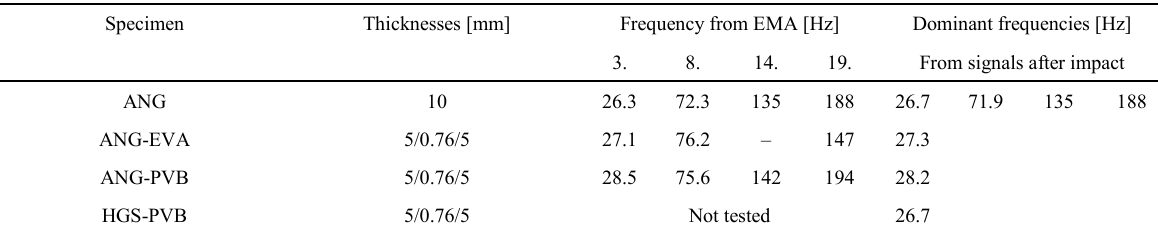
Table 1: Comparison of natural